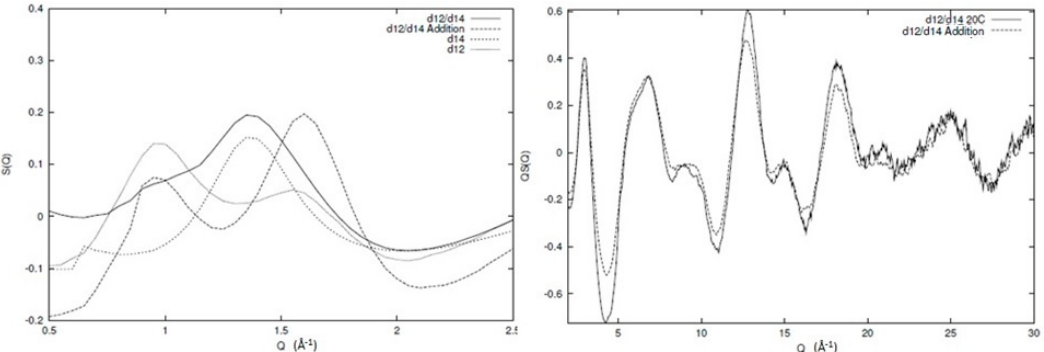
Figure 4. Comparison of the experimentally observed structure factor for a blend of deuterated 1,2 (d12) and 1,4 (d14) polybutadiene (d12/d14) with an artificial structure factor (d12/d14 addition) comprising the sum of the experimentally observed structure factors of the two individual components weighted by their relevant concentration. See text for more detailed discussion